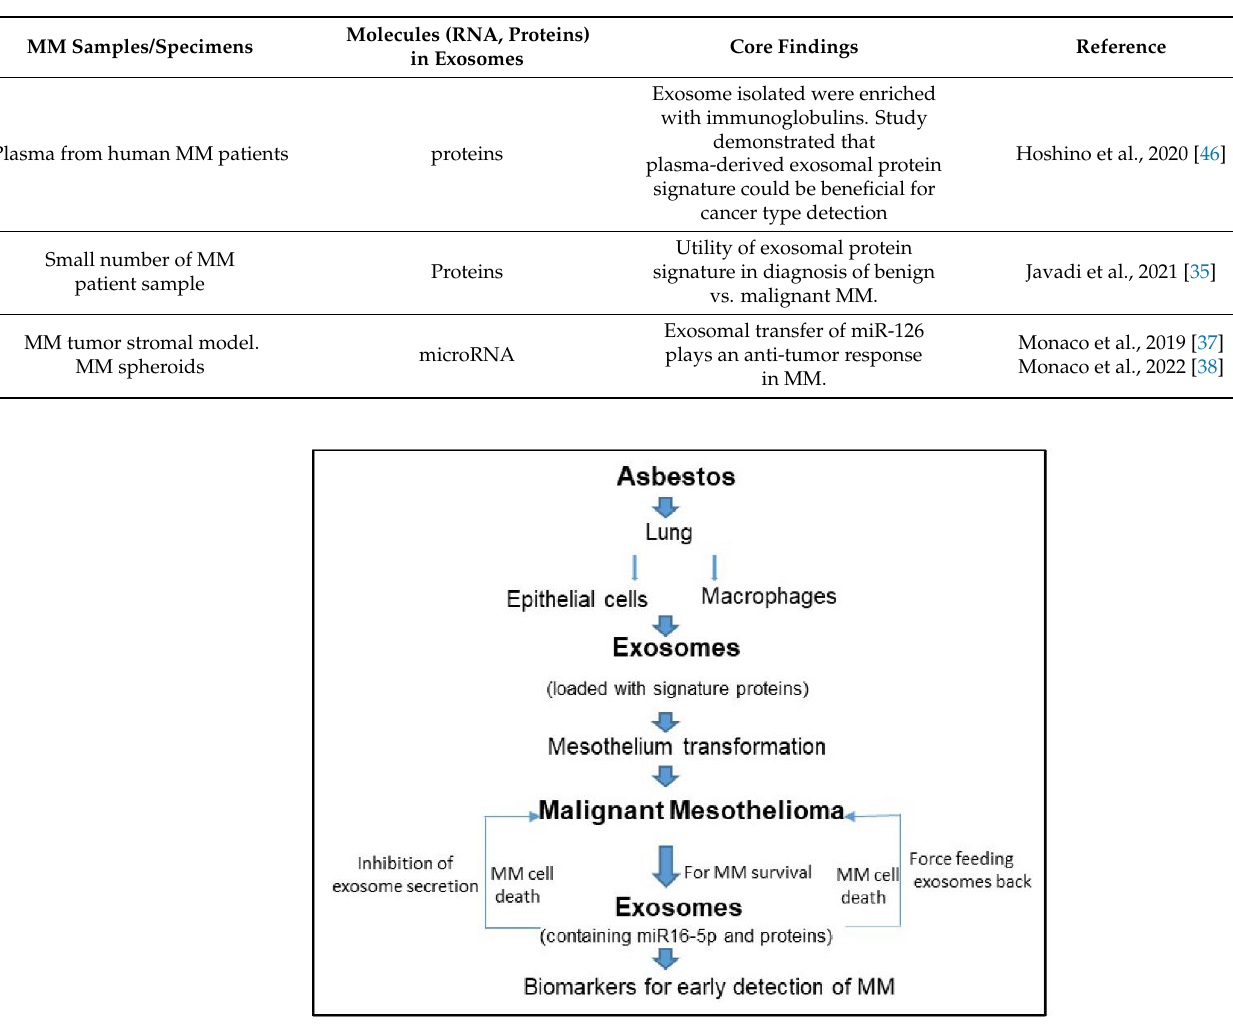
Figure 1. Asbestos inhalation results in lung epithelial cells and macrophages to release exosomes, which are loaded with a special protein and RNA molecules. These exosomes can travel to the mesothelium and transform them so as to develop malignant mesothelioma. Malignant mesothelioma cells/tumors secrete exosomes that are loaded with miR16-5p (tumor suppressor miRNA) to survive. Inhibition of exosome secretion or feeding them back to MM cells results in MM cell death. Protein signature in secreted MM tumor exosomes can be utilized to detect